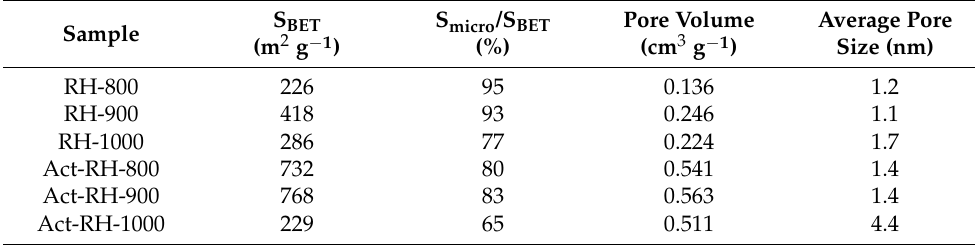
Table 2. Pore structure parameters of the investigated